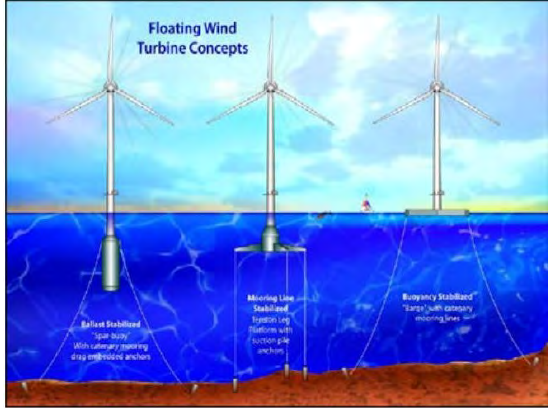
Figure 2. Floating platform concepts for OWT (Jonkman, & Buhl,